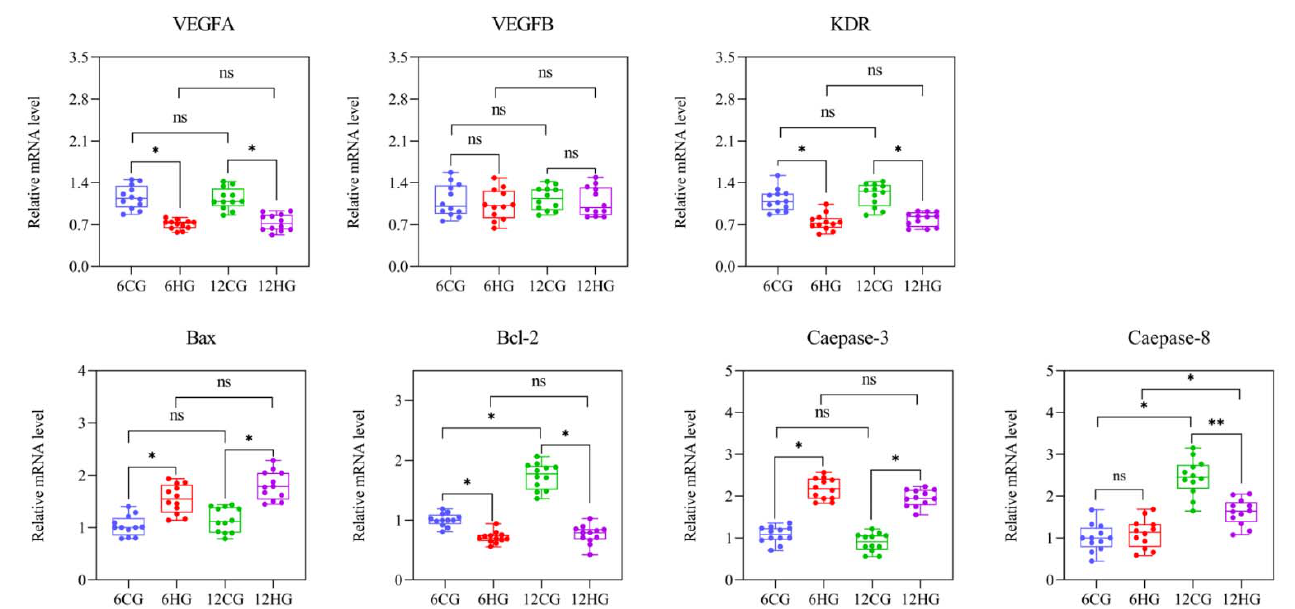
Nile tilapia ( Oreochromis niloticus ) ovary under heat stress. Note: ( A ) n = 12. * indicates statistical significance between heat-stressed group and control group ( p < 0.05). ( B ) Representative images of Western blot from female fish in 6CG, 6HG, 12CG, and 12HG. ( C ) 1–4: Red arrow indicates positive expression of TGF β 1I1 protein (scale bar: 50 μ m). Red arrows indicate positive signal of TGF β 1I1 protein. A and C correspond to control group (CG) on days 6 and 12, respectively; B and D corre- spond to heat-stressed group (HG) on days 6 and 12, respectively.